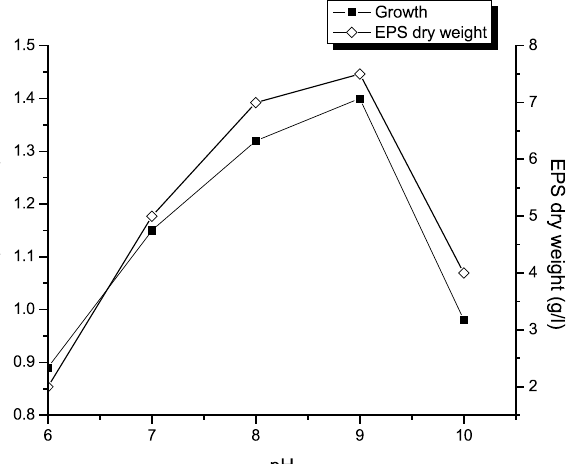
Fig. 4. Effect of pH on growth and EPS production by Halomonas sp. NASH. Fermentations were carried out in IRAM medium under continuous shaking (200 rpm) at different initial pH ranging from 6-10 and temperature at 37°C with 1% (v/v) initial inoculum.